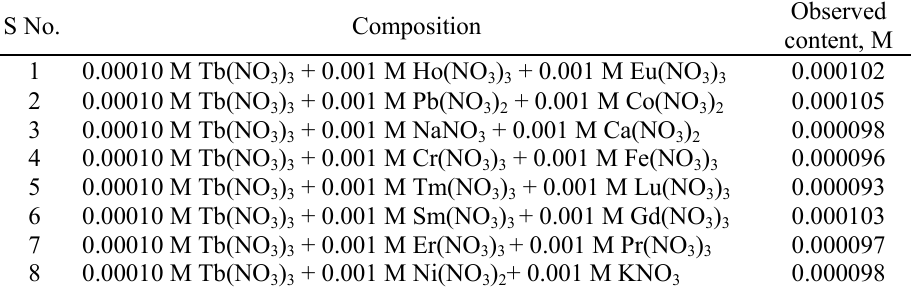
Table 3. Determination of Tb 3+ ions in mixtures of different ions